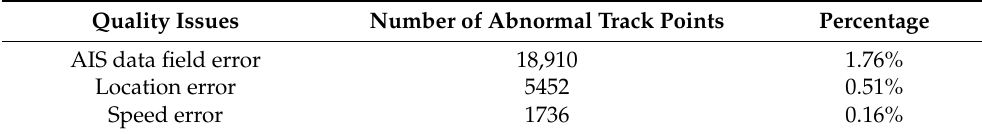
Table 4. Trajectory accuracy repair results.